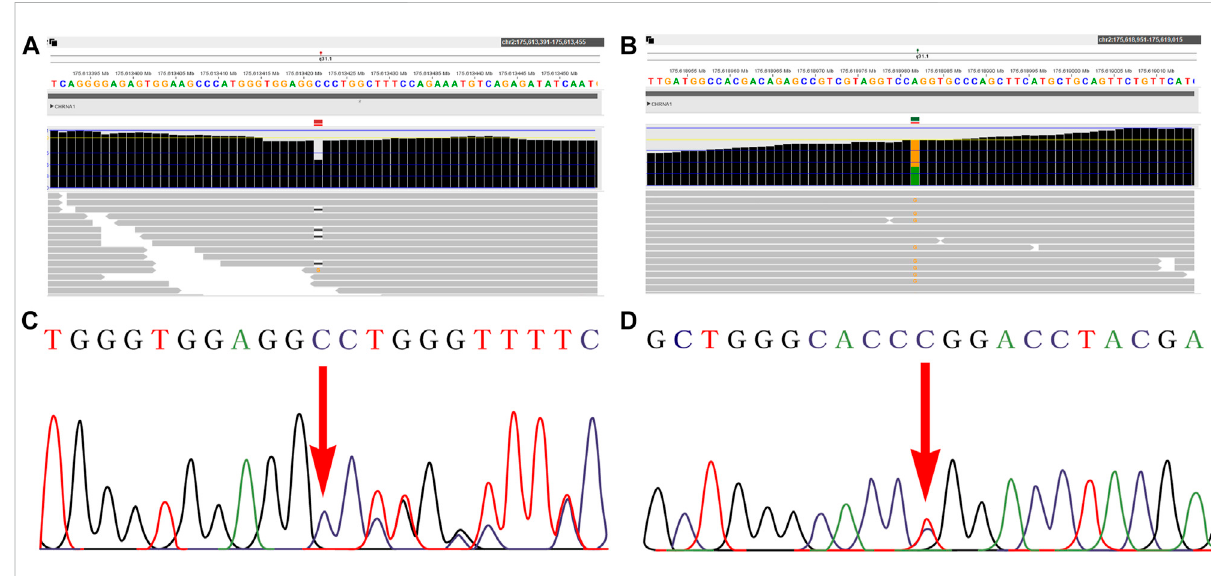
FIGURE 2 Novel variants of the CHRNA1 gene identi fi ed in the fetus. A – B : WES detection results demonstrated novel compound heterozyous variants in the CHRNA1 gene NM_000079.4: c.[1128delG (p.Pro377Leu fs Ter10)]; [505T > C (p.Trp169Arg)] in the fetus. C – D : both variants were further con fi rmed by Sanger